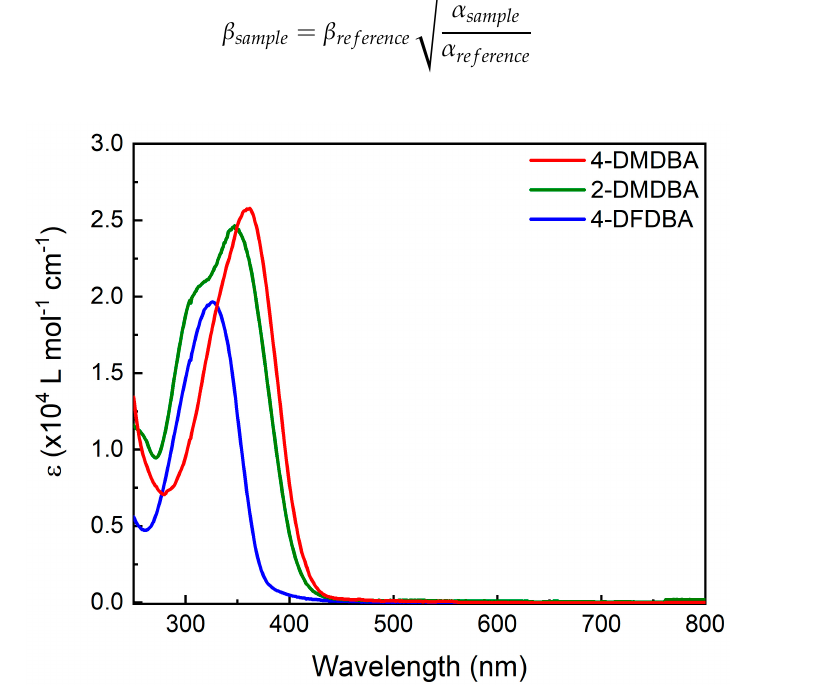
Figure 2. The molar absorption coefficient ( ε ) as a function of the wavelength of all studied compounds.